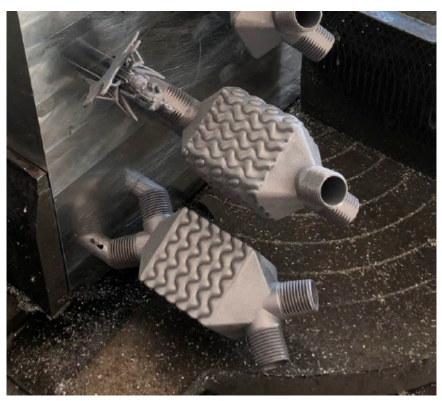
Figure 11. View of the heat exchangers used in the research by the authors of [130].